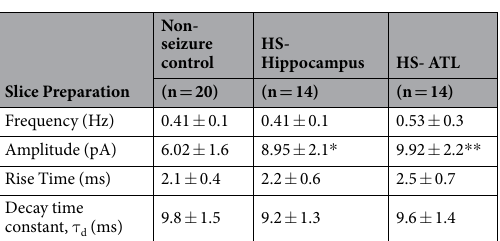
Table 3. Kinetic properties of miniature EPSCs (mEPSCs). Characteristics of mEPSCs recorded from pyramidal neurons in resected samples from non-seizure control and the hippocampal and ATL samples from HS patients in the presence of ACSF containing TTX (200 nM). The data are presented as the mean ± S.E.M. * p = 0.05; ** p = 0.007 compared to non-seizure control according to one-way ANOVA followed by Tukey post hoc